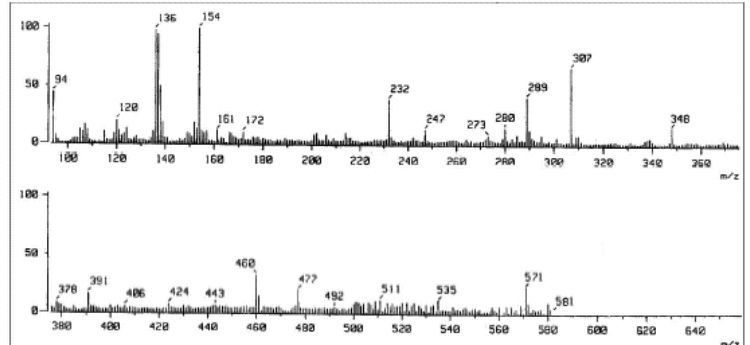
Figure 1. FAB-Mass spectra of cuprous product.